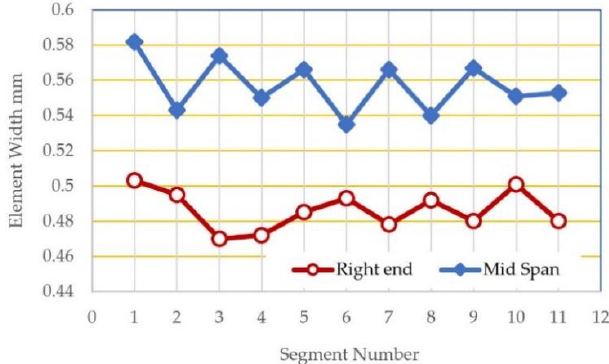
Figure 21. Nonuniform element width resulted from the C-U cutting mode.